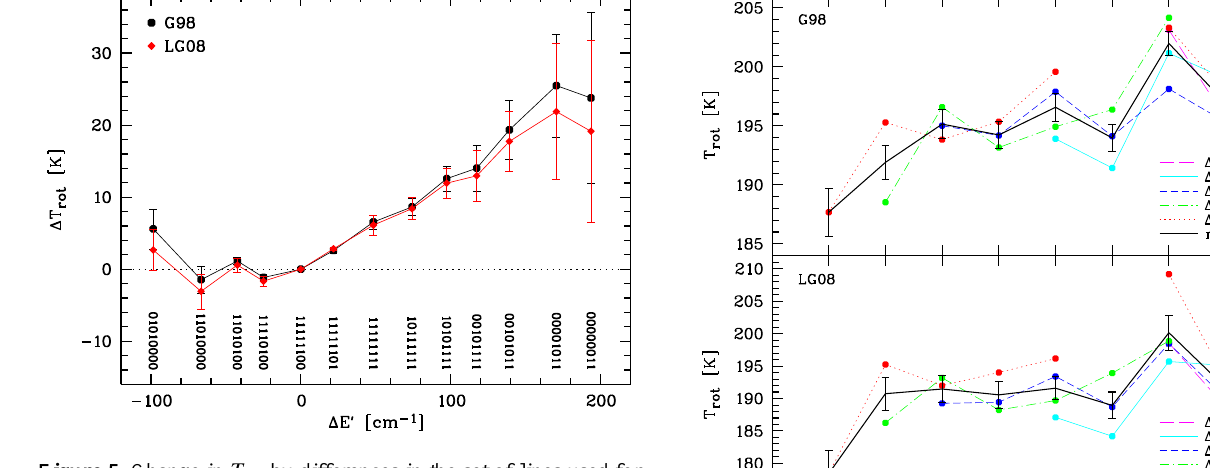
Figure 5. Change in T rot by differences in the set of lines used for its determination. The difference in T rot and the mean energy of the upper rotational levels of the selected lines are given relative to the reference line set consisting of the first three P 1 - and P 2 - branch lines. The plotted data points indicate the mean values and mean errors for the OH bands (4-1), (5-2), (6-2), and (7-4). Black circles and red diamonds show the results for the G98 and LG08 line parameters, respectively. The set of lines for each data point is indicated by an eight digit binary number. Selections are marked by the number 1. The position of a digit corresponds to the wavelength of a P -branch line (see Fig. 2 and Table 1), i.e. the first and last digit refer to P 2 (1) and P 1 (4), respectively.